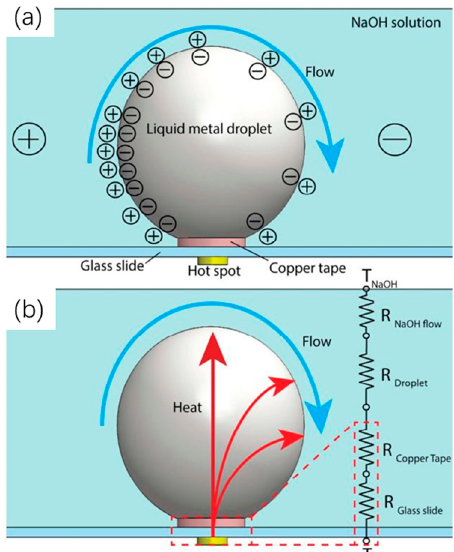
Figure 3. Schematic of mechanism of electrical actuated liquid metal droplet on a hot spot based on the Marangoni effect. ( a ) The generation of harmonic Marangoni flow and surface charge distribution of liquid metal droplet when an electric potential is applied between the electrodes. is enabled by continuous electrowetting effect at the surface of the liquid metal droplet, upon the application of a square wave DC signal. ( b ) Schematic and equivalent thermal circuit of heat dissipation through liquid metal droplet, where T is temperature and R is thermal resistance. Reproduced with permission from [32]; published by ACS Publications, 2016.